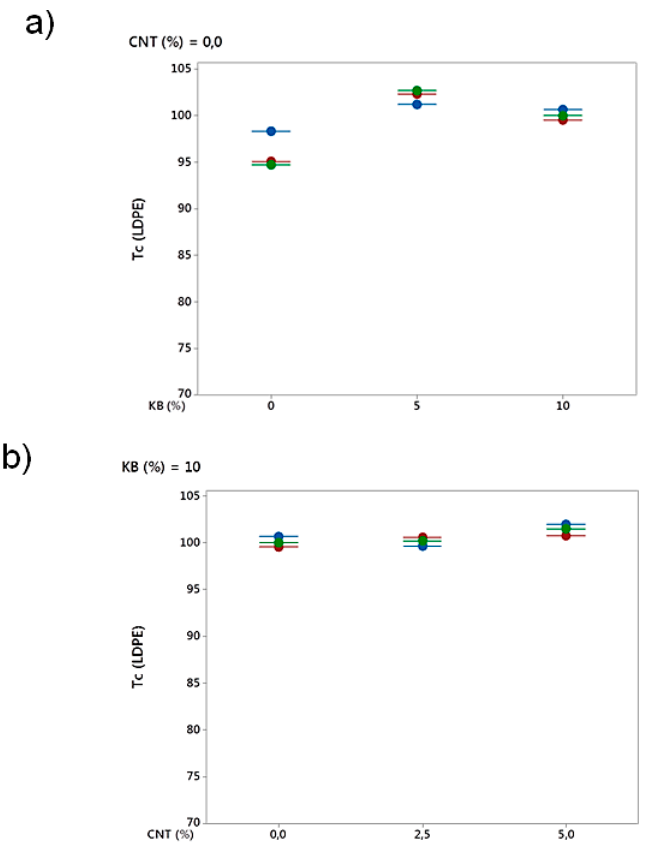
Figure 12. E ff ect of percentages of KB ( a ) and CNT ( b ) on the T c ( ◦ C) of the conducting biphasic Figure 12. Effect of percentages of KB ( a ) and CNT ( b ) on the (cid:1794) (cid:1803) (°C) of the conducting biphasic LDPE-based CPC/PBE blends. The blends 100%LDPE-based CPC/0%PBE, 60% LDPE-based CPC/ LDPE-based CPC / PBE blends. The blends 100%LDPE-based CPC / 0%PBE, 60% LDPE-based CPC / 40%PBE and 40% LDPE-based CPC/60%PBE are represented in blue, red and green, respectively. 40%PBE and 40% LDPE-based CPC / 60%PBE are represented in blue, red and green, respectively.